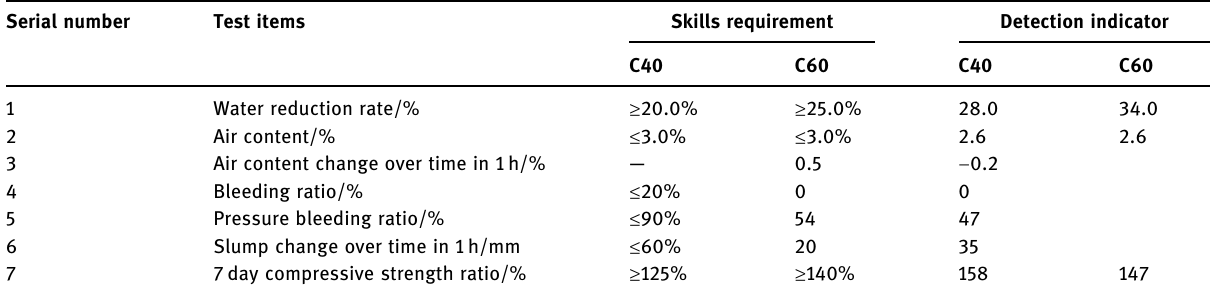
Table 3: Main performance indexes of water reducing agents Serial